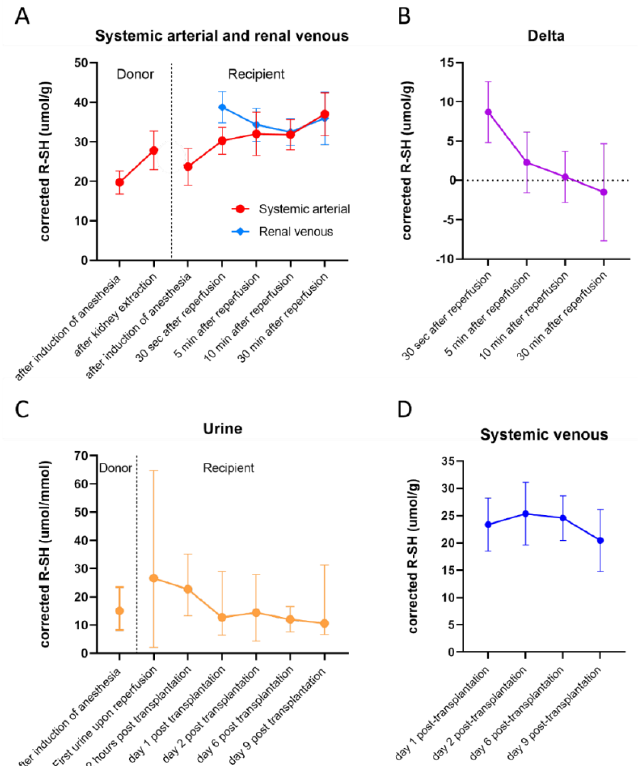
Figure 1. R-SH levels in samples types in donors and recipients. Data given as mean (±SD) or median (IQR). R-SH is corrected by plasma albumin levels or urinary creatinine levels. ( A ): Mean systemic arterial (µmol/g) and mean renal venous R-SH (µmol/g) in donors and recipients. ( B ): Mean delta (renal venous-systemic arterial) R-SH (µmol/g) in recipients. ( C ): Median urinary R-SH (µmol/mmol) in donors and recipients. ( D ): Median systemic venous R-SH (µmol/g) in recipients. Abbreviations: R-SH: free sulfhydryl groups.